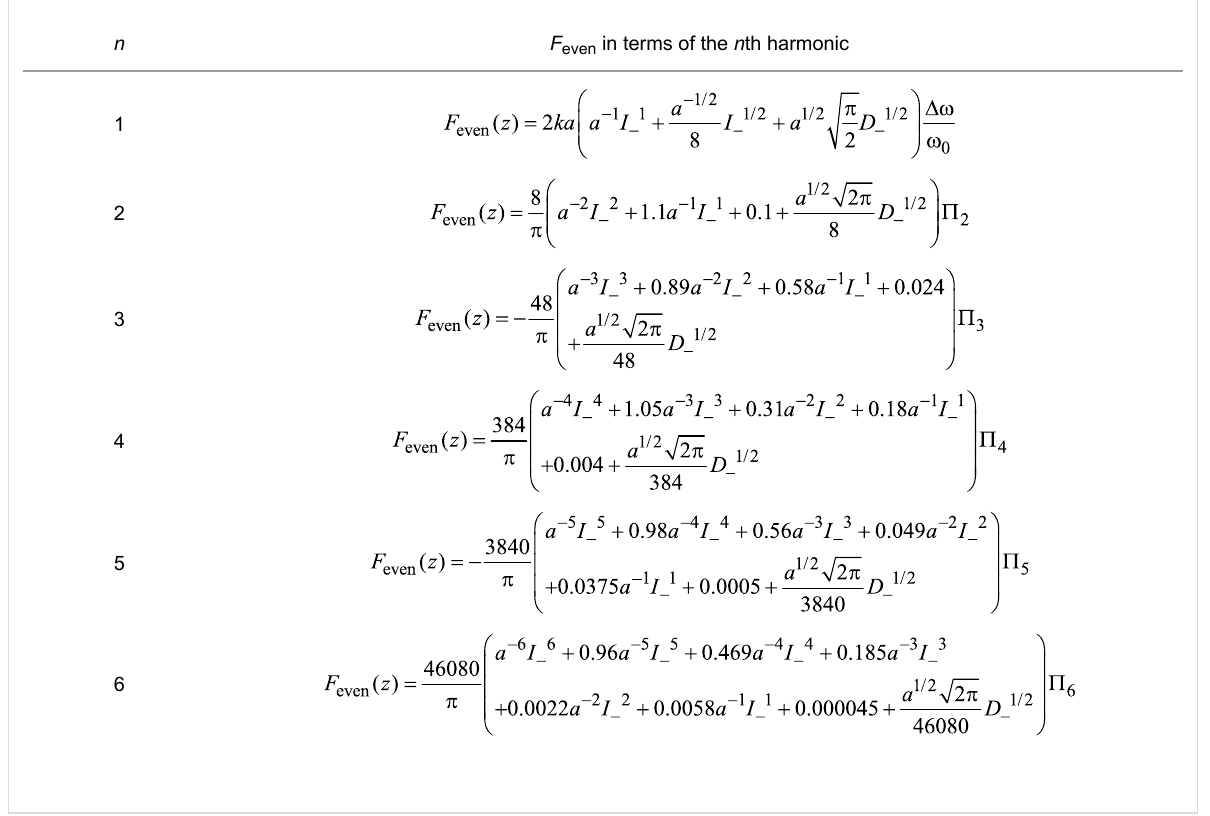
Table 1: Formulae for the force in terms of harmonics 1–6. The Sader–Jarvis formula for n = 1 is given here for completeness. An implementation of these formulae is available in the supplementary Mathematica